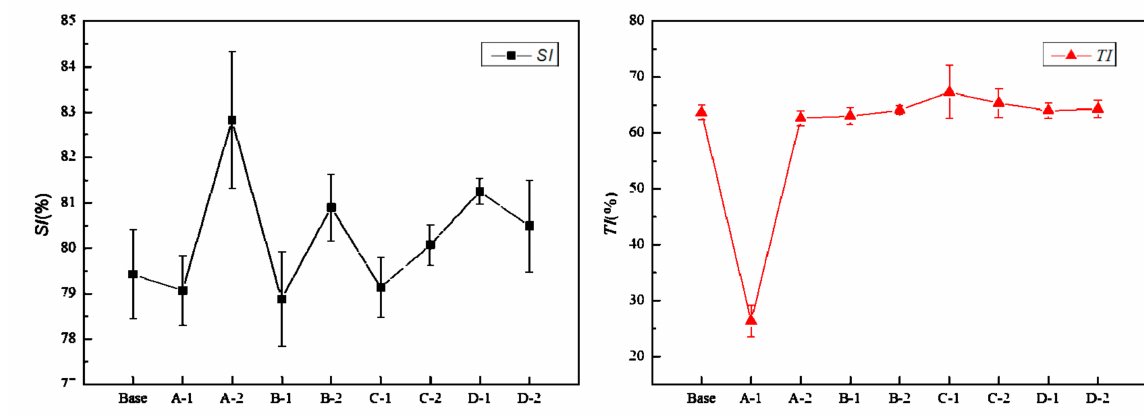
Figure 16. Influences of the sinter parameters on sinter